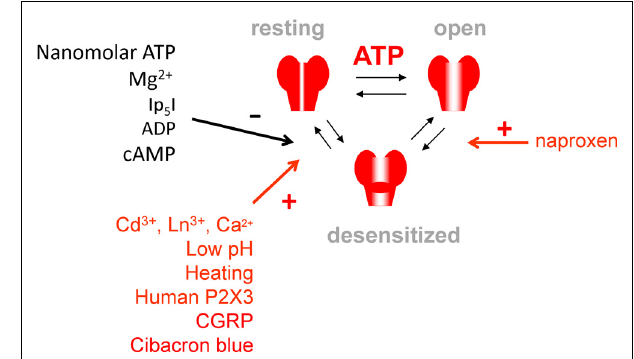
FIGURE 1 |A simplified kinetic scheme for P2X3 receptor operation indicating resting, open and desensitized receptor states. Note multiple factors accelerating ( + , red arrow) or retarding ( − , black arrow) recovery from desensitization, while naproxen promotes desensitization onset. Factors accelerating recovery are expected to facilitate ATP signaling via P2X3 receptor activity, whereas factors retarding recovery (or promoting desensitization onset) could provide the anti-nociceptive